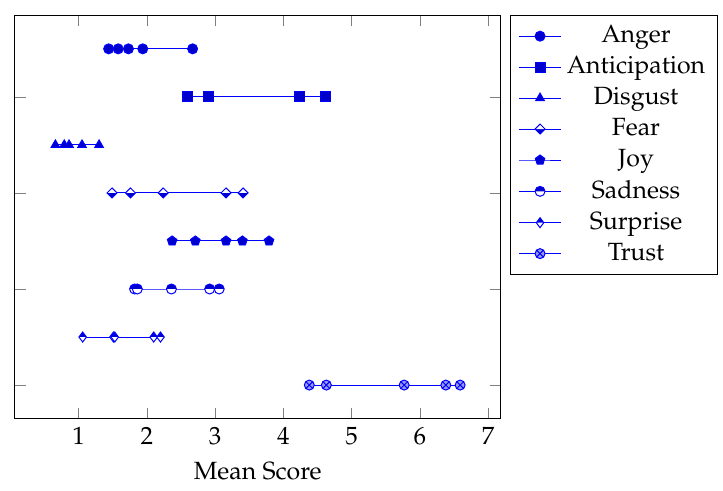
Figure 4. Mean sentiment scores for the five